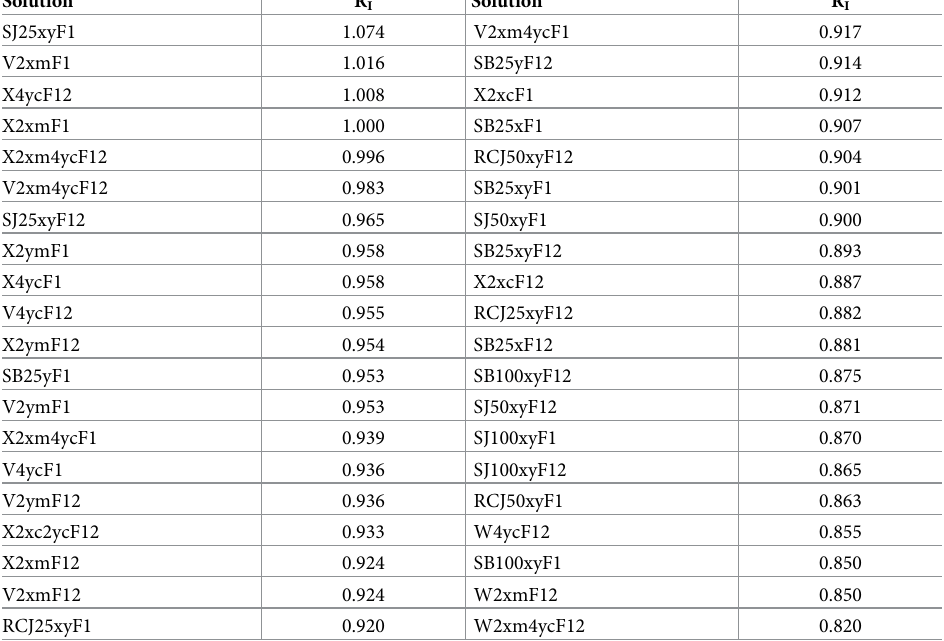
Table 5. Rehabilitation index of each